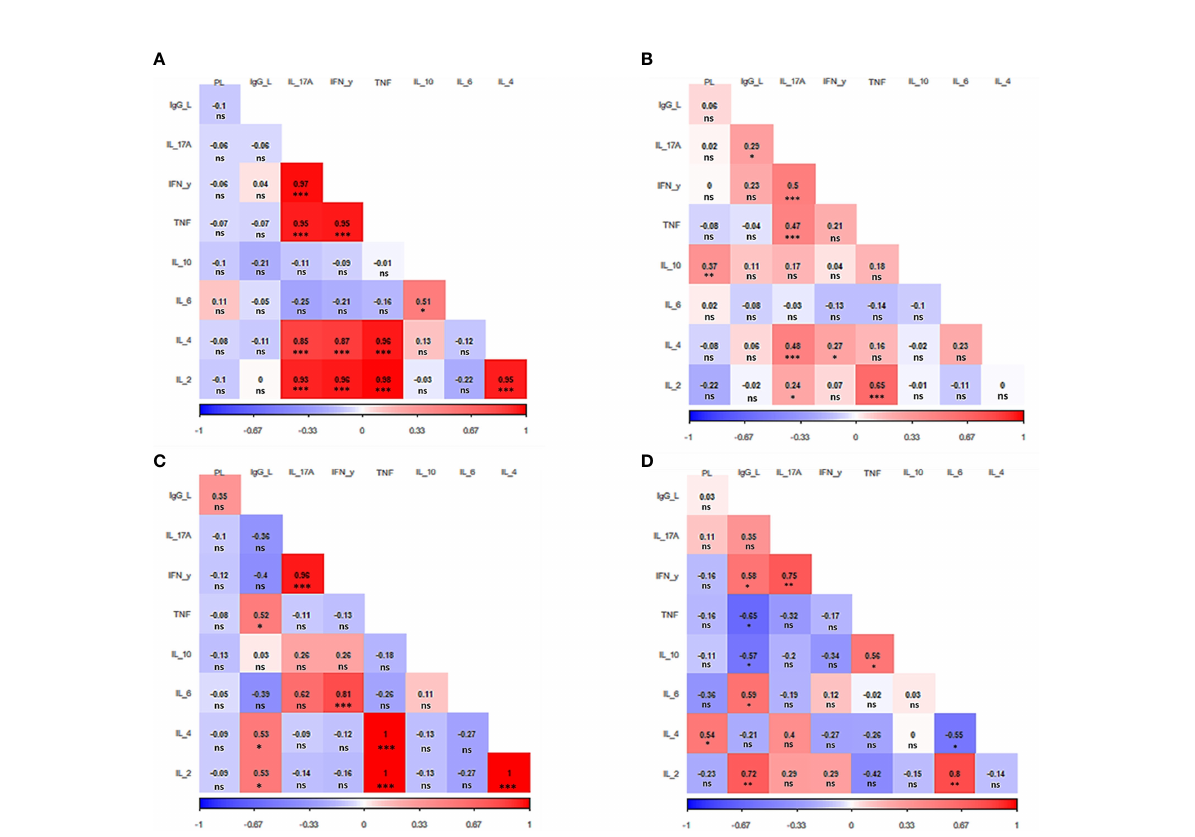
FIGURE 3 Correlation analysis heat map. The heat map shows the correlation among IgG anti- Leishmania titers, parasite load, and cytokine production for each clinical manifestation evaluated (A) Asymptomatic. (B) Primary cutaneous leishmaniasis. (C) Recurrent leishmaniasis. (D) Mucocutaneous leishmaniasis. PL. parasite load, IgG_L: anti- Leishmania titers IL: interleukin. IFN- g : interferon g . TNF: tumor necrosis factor. The value observed in each square is the Pearson correlation coef fi cient.* p < 0.05, ** p < 0.01, *** p < 0.001, ns – non-signi fi